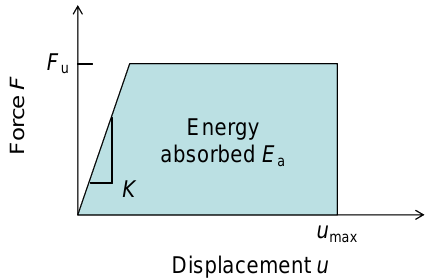
Figure 1. Schematic of elastic-plastic deformation describing the inelastic collision while loading the snow column in a compression test. K denotes the stiffness (equivalent to a spring constant) (after Wright, 2012).